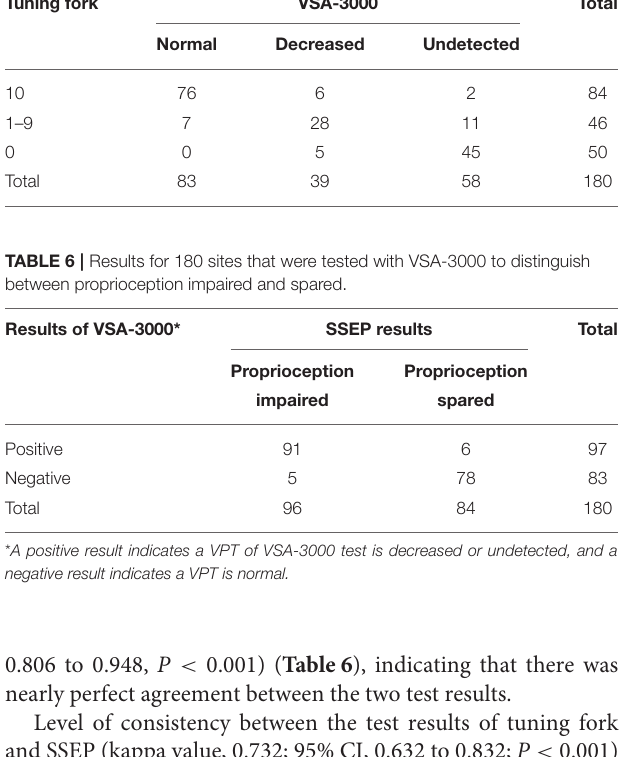
TABLE 7 | Results for 180 sites that were tested with tuning fork to distinguish between proprioception impaired and